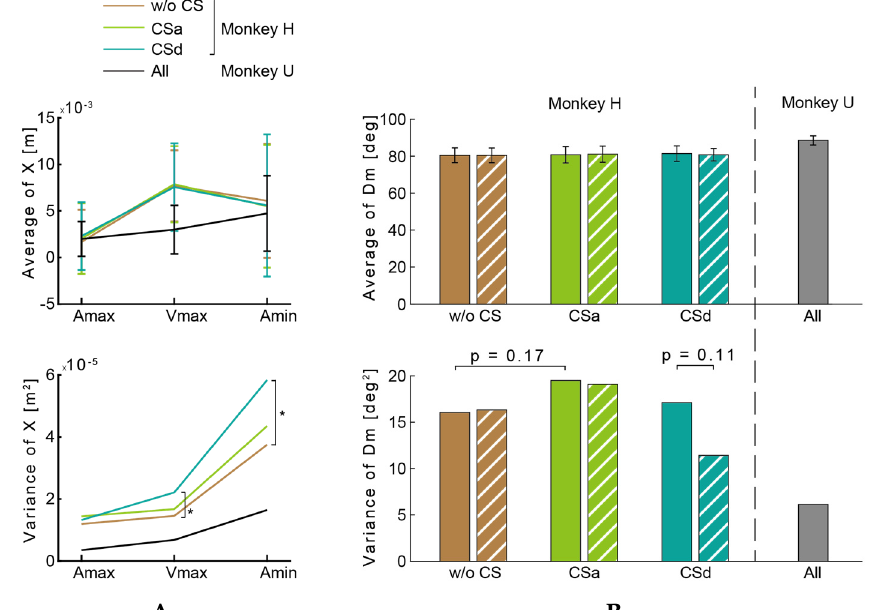
Figure 4. Effects of the CS on accuracy and precision of the hand movement in the hitting task are shown. Trials are grouped into three depending on the types of saccades during the trial in Monkey H; those without (w/o) CS (520 trials), with CSa (199 trials), and with CSd (67 trials). As a comparison, the result of all trials in Monkey U (556 trials) is also shown. ( A ) Top and bottom panels: average and variance of the cursor position in x-coordinate are shown, respectively (* p < 0.05). They are evaluated at cursor acceleration maximum (Amax), velocity maximum (Vmax), and acceleration minimum (Amin) point during the hand movement. ( B ) Top and bottom panels: average and variance of movement direction (Dm) are shown, respectively. The current and subsequent trials are shown as filled boxes and white oblique-lined boxes, respectively. An error bar represents a standard deviation in all panels.